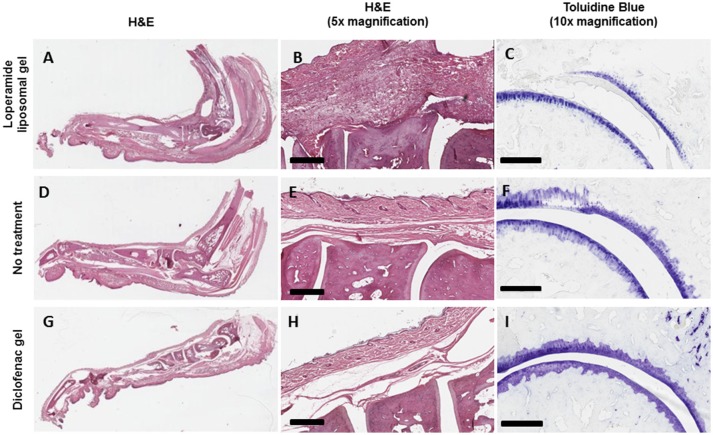
Increase in the degree of histopathologic abnormality in the joints of AIA animals treated with loperamide liposomal gel (A–C) compared to AIA animals administered no treatment (D–F) and diclofenac gel (G–I). (A,B) Increase in pannus formulation, synovial inflammation, immune cell infiltration, and bone damage (haematoxylin and eosin, H&E). (C) Increase in cartilage degradation (toluidine blue). Representative pictures are shown. Scale = 500 μm (H&E) and 300 μm (toluidine blue).